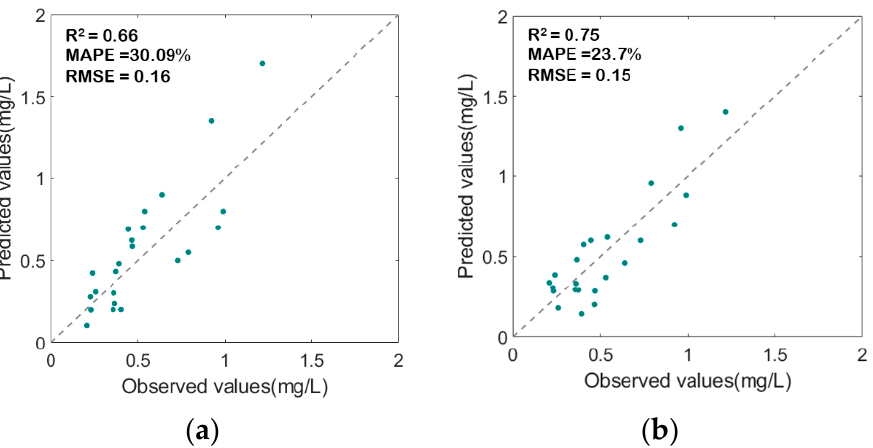
Figure 7. Accuracy assessment results of NH3-N estimated by the statistical regression models and random forest model using SR-FSDAF fused images. The X-axis is the observed data, and the Y-axis is the predicted data. ( a ) used the statistical regression models (quadratic model); ( b ) used random forest model.